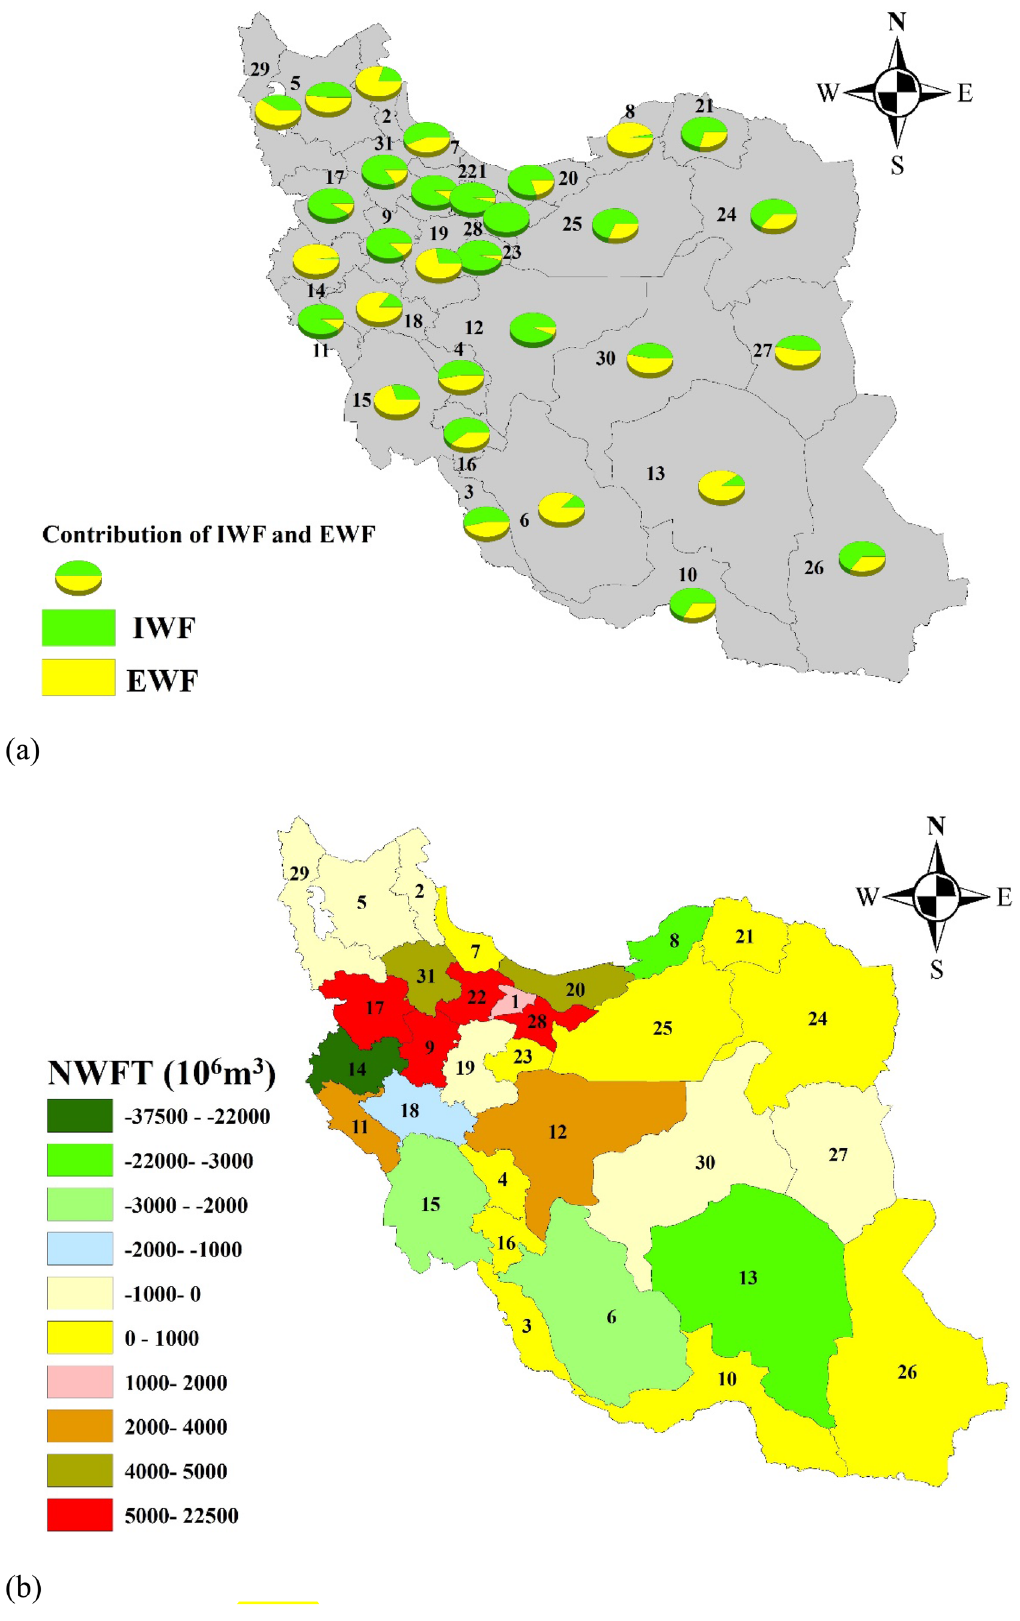
Figure 5. The shares of exported (EWF) and imported (IWF) water footprints ( a ), and net water footprints trade (NWFT) ( b ) Positive sign denotes net water footprint imports; a negative sign denotes net water footprints export (ArcGIS